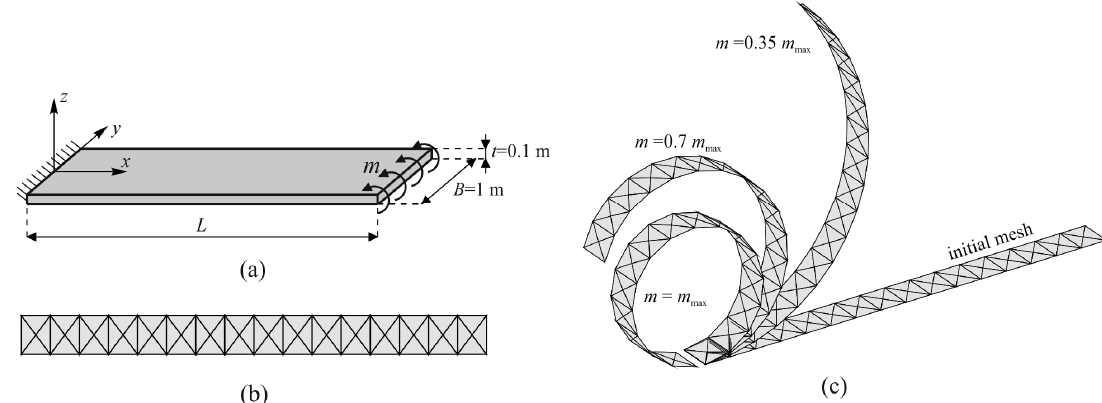
Figure 13. Cantilever exposed to end moment: ( a ) geometry; ( b ) discretisation; ( c ) deformed finite element mesh under different loading stages.